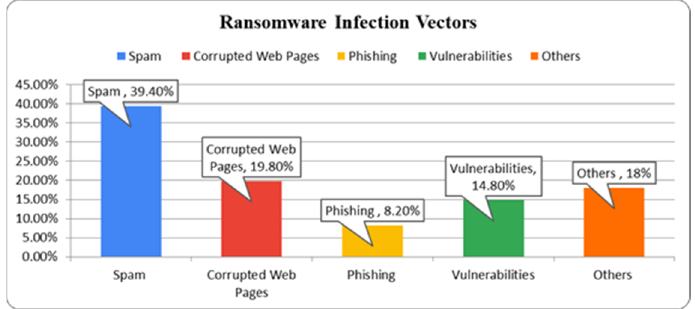
Table 2. Comparison Between Ransomware Malware Behavior Types.